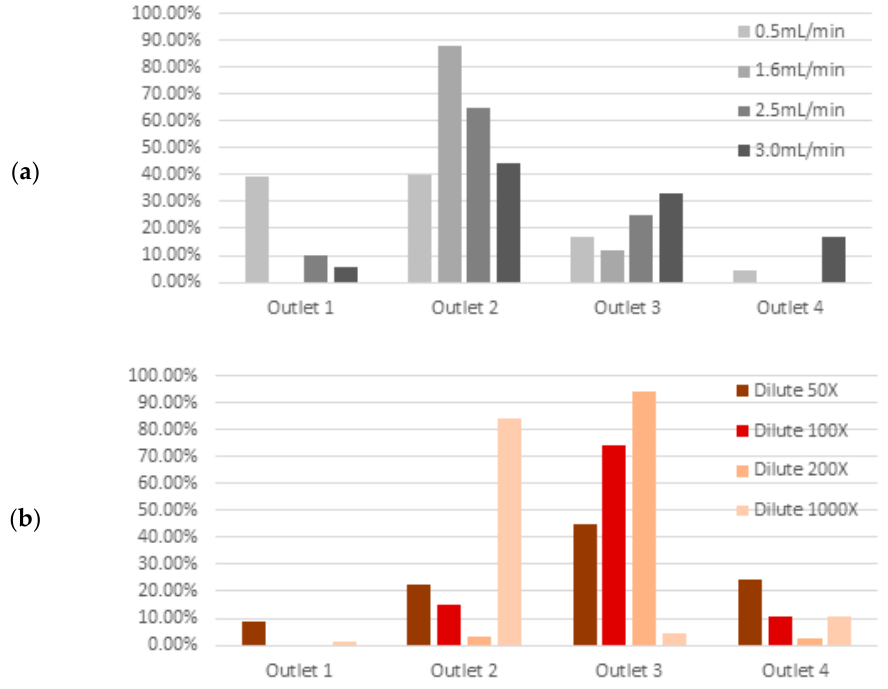
Figure 6. Blood cell separation efficiency, ( a ) using only white blood cells at 100X dilution while varying flow rate, an ( b ) using only red blood cells at 1.9 mL/min while varying concentration.